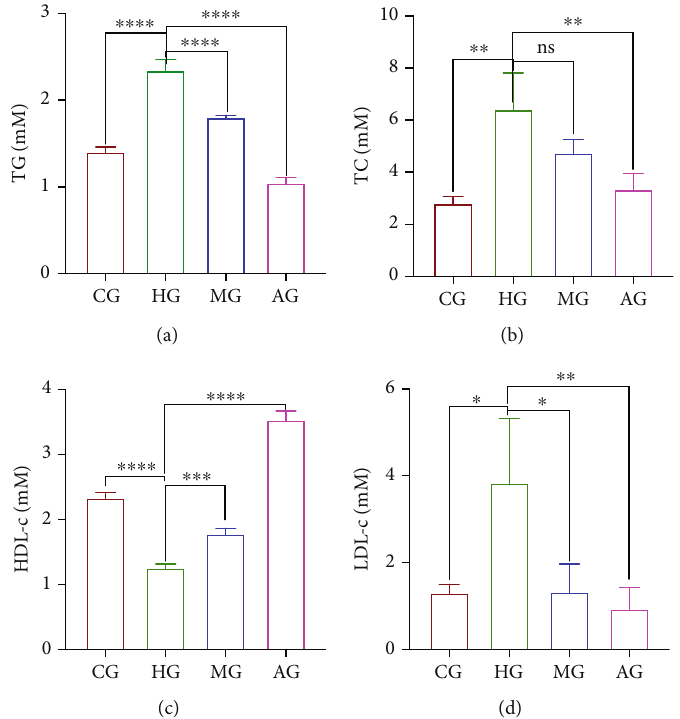
Figure 5: The e ff ects of Kluyveromyces marxianus on lipid pro fi les. (a) TG. (b) TC. (c) HDL-c. (d) LDL-c. n = 3 for each group, and ns P > 0 : 05 , ∗ P < 0 : 05 , ∗∗ P < 0 : 01 , ∗∗∗ P < 0 : 001 , and ∗∗∗∗ P < 0 : 0001 vs. the HG group.